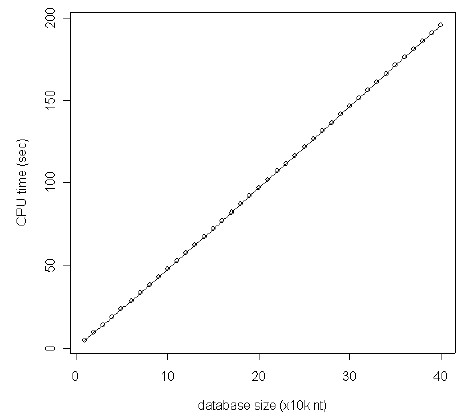
CPU time versus database size. From the 5S rRNA family, a randomly picked 5S rRNA was used as the query to search a structure database obtained by folding the rest seed sequences in the family. The program was run 10 times, and the average running time of each time is shown as a circle in the graph.